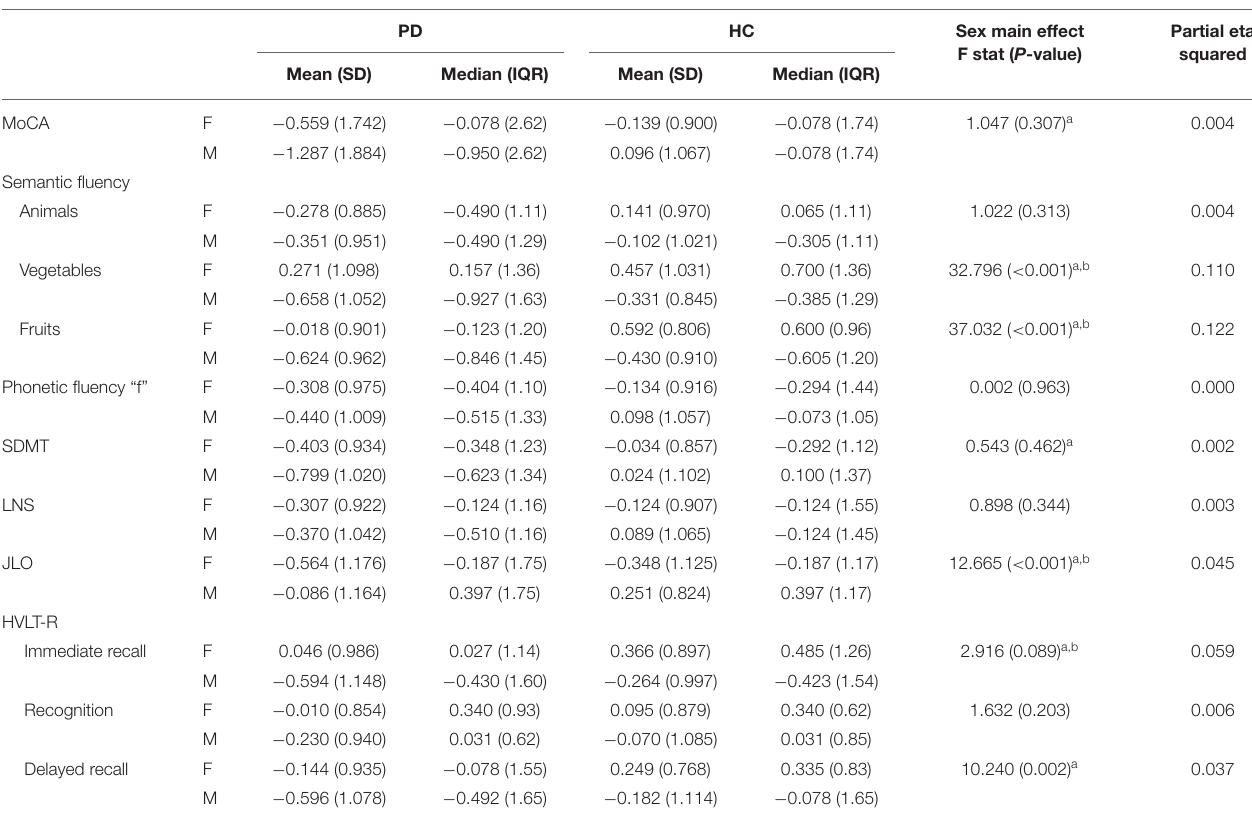
TABLE 2 | Neuropsychological performance of PD and HC females and males. PD HC Sex main effect